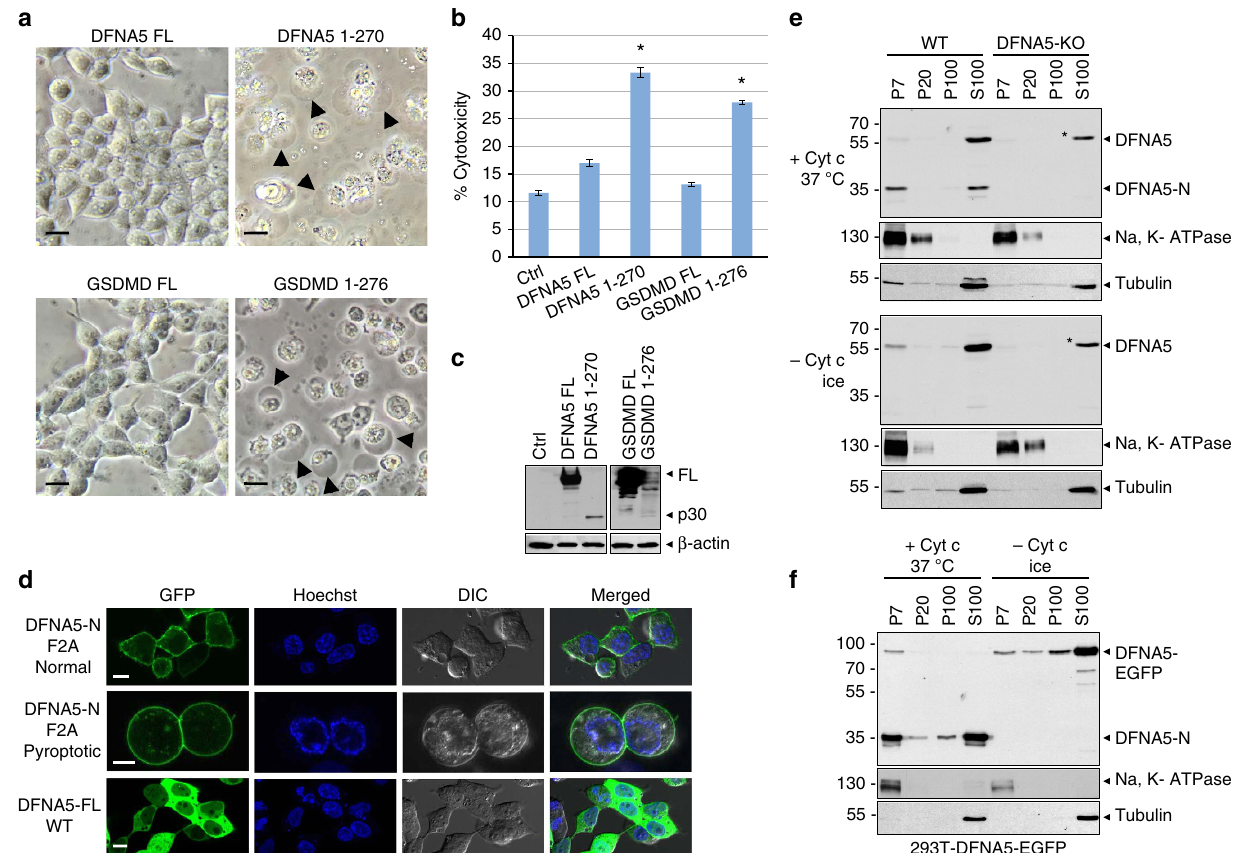
Figure 3 | The cleaved N-terminal DFNA5 fragment has intrinsic necrotic activity. ( a ) Microscopic images of 293T cells transfected with expression constructs for full-length DFNA5 (DFNA5 FL), full-length GSDMD (GSDMD FL), DFNA5-N (DFNA5 1–270) or GSDMD-N (GSDMD 1–276) as indicated. Arrowheads indicate ballooned cell membrane characteristic of necrotic/pyroptotic cells. Scale bar, 20 m m. ( b ) Cytotoxicity of DFNA5 and GSDMD and their fragments as measured by LDH release in the culture supernatants of 293T cells transfected with the indicated expression constructs for DFNA5 and GSDMD. ( n ¼ 3) * P o 0.001, Student’s t -test. ( c ) Immunoblots showing the expression of the proteins in ( b ). The lower expression of DFNA5 1–270 and GSDMD 1-276 fragments is due to their toxicity. ( d ) Confocal images of the DFNA5-N-F2A-EGFP mutant (upper and middle), or full-length WT